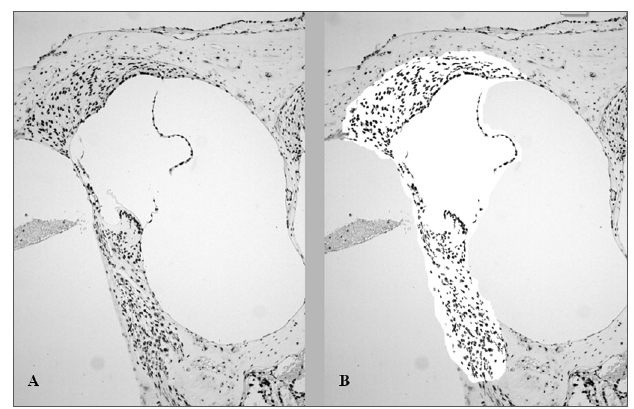
Figure 1. Histomorphometric analysis, after TUNEL immunohistoche- mistry technique, of an animal treated with 16mg/kg of cisplatin, which had its cochlea removed on D3. The brown color indicates cell death. A. Color seen before selection and quantification of the dyed area. B. After selection of the area to be analyzed by the SAMH 1.0 software, isolating the brown